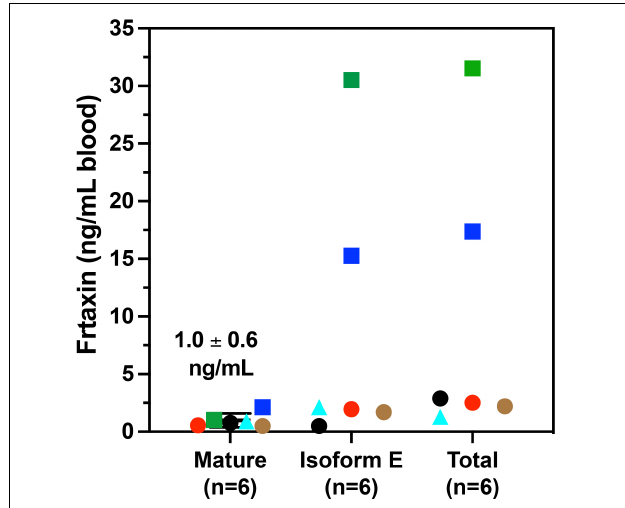
FIGURE 5 | Whole blood frataxin levels in controls and compound heterozygous cases in year 1 ( n = 6). (cid:4) M1S (c.2 del T); (cid:4) A34P (c.100